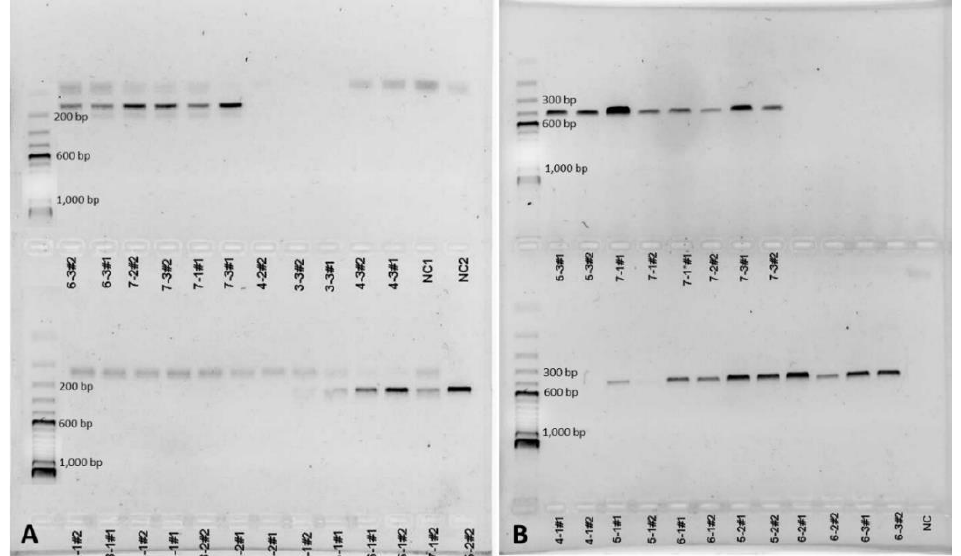
Figure 6. Examples of PCR results obtained with both diagnostic primer pairs using soil DNA extracts (5–7 cm depth) from Antelope Acres west of EAFB. Amplicons obtained with primer pair ITSC1Af / r (~120 bp) ( A ). Amplicons obtained with primer pair EC3 / EC100 (~500 bp). A 100 bp DNA ladder can be seen in the 2% agarose gel on the left ( B ) (PC = positive control, NC = negative control). Table 5. Diagnostic PCR results for all soil DNA extracts ( n = 389) (ITSC1Af/r and EC3f/EC100r). Detection of Coccidioides spp.